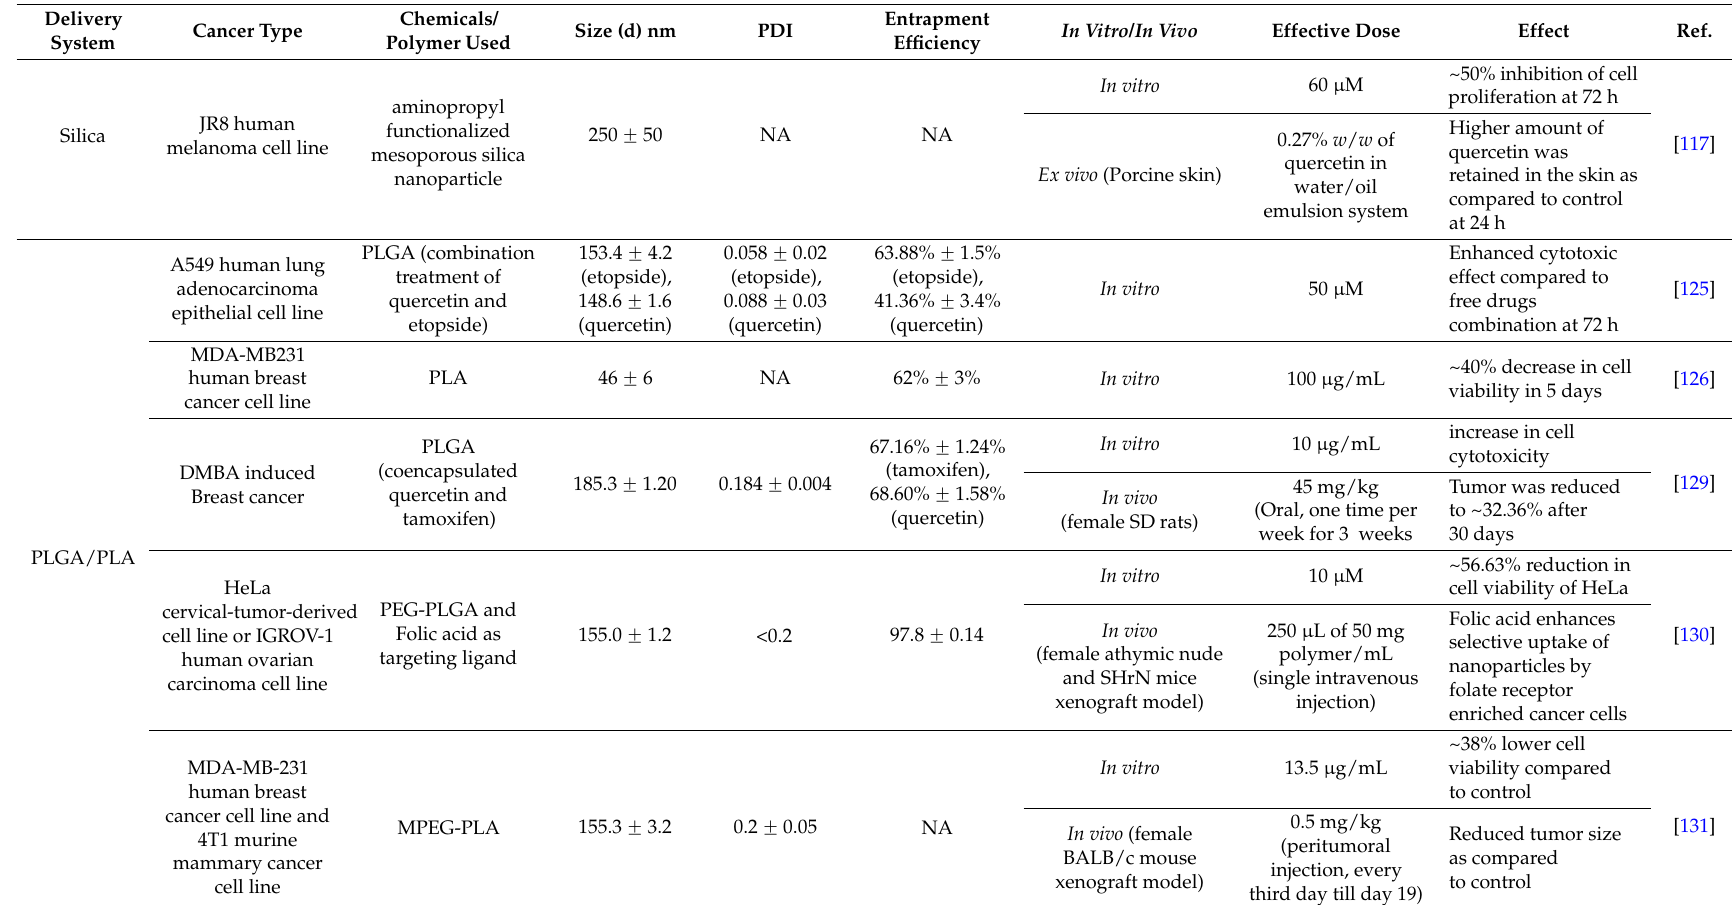
Table 2. The physico-chemical properties and anti-cancer effects of quercetin based nanoparticle